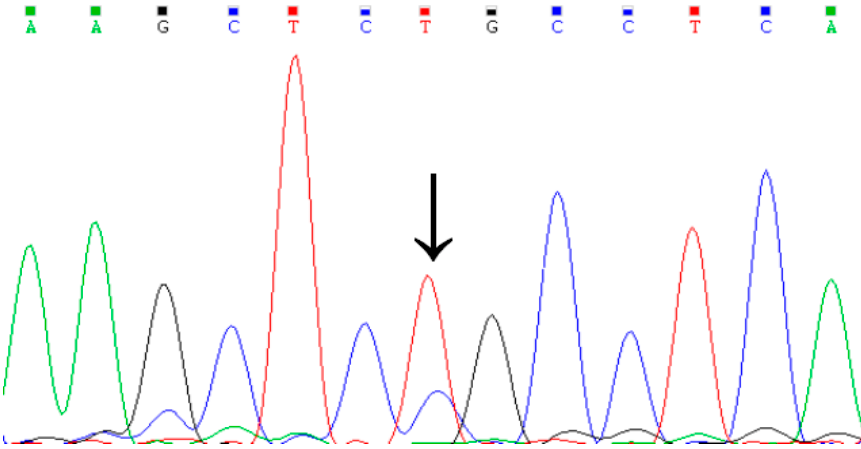
Figure 1. Sequencing result of the g.35989944T>C mutation in the KCNJ12 gene.